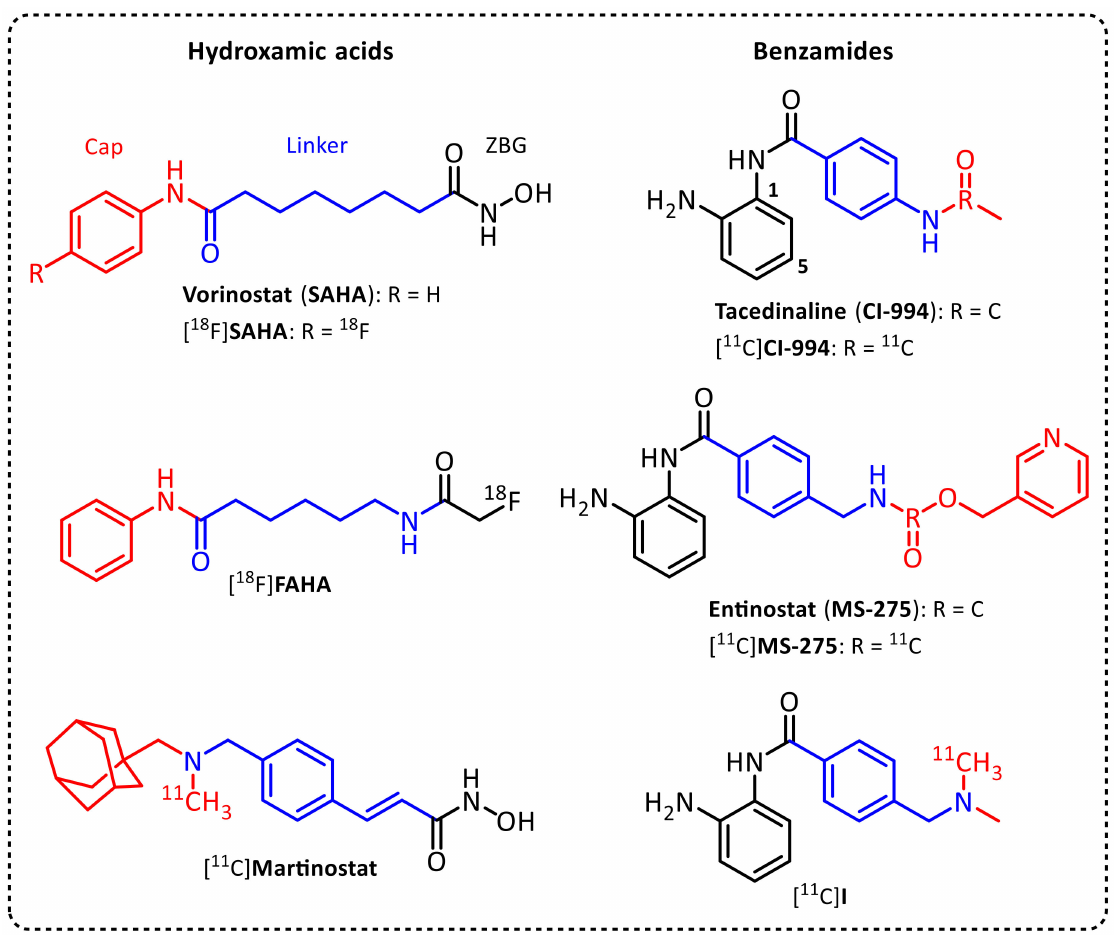
Figure 1. Pharmacophore model and structures of selected hydroxamic acids and benzamides as HDAC inhibitors and their corresponding PET